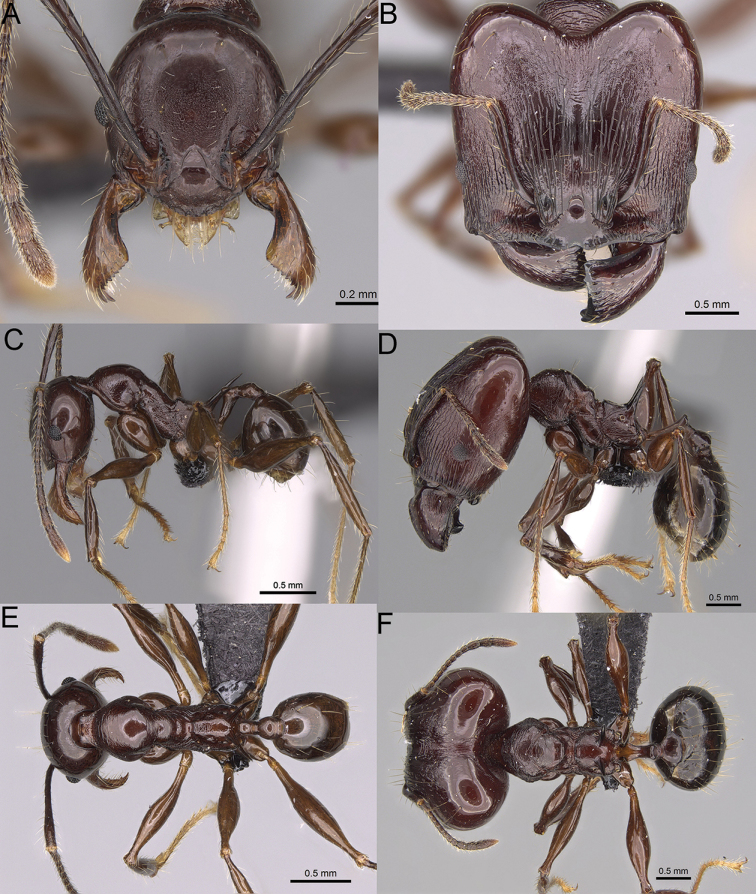
Pheidole
mahaboensis sp. nov., full-face view (A), profile (C), and dorsal view (E) of paratype minor worker (CASENT0070926) and full-face view (B), profile (D), and dorsal view (F) of holotype major worker (CASENT0070925).